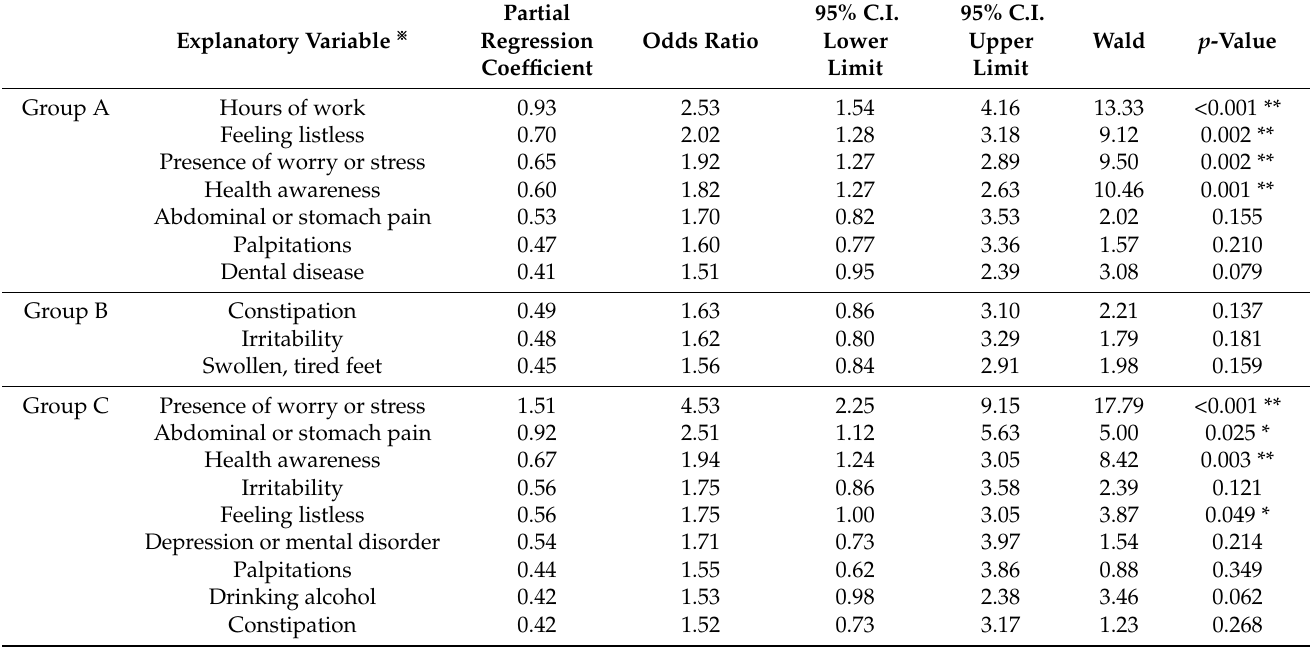
Table 7. Results of multinomial logistic